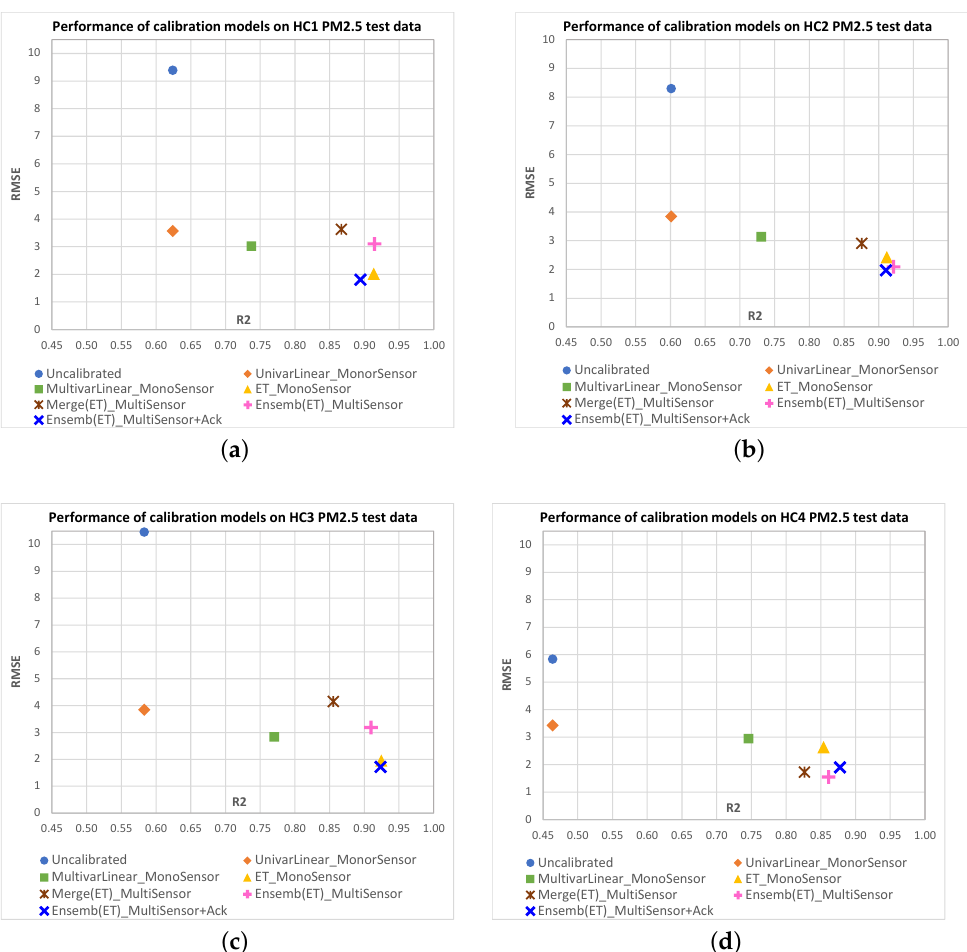
Figure 8. Scatterplots of R 2 vs. RMSE mean values obtained on test data for each IQAir PM 2.5 sensor as candidate sensor with the different calibration models. The ideal performance is the point with RMSE = 0 and R 2 = 1, which is the lower right corner of the plots. Points closest to that corner represent models with better performance. Subfigures correspond to the following PM 2.5 candidate sensors: ( a ) HC1; ( b ) HC2; ( c ) HC3; ( d )